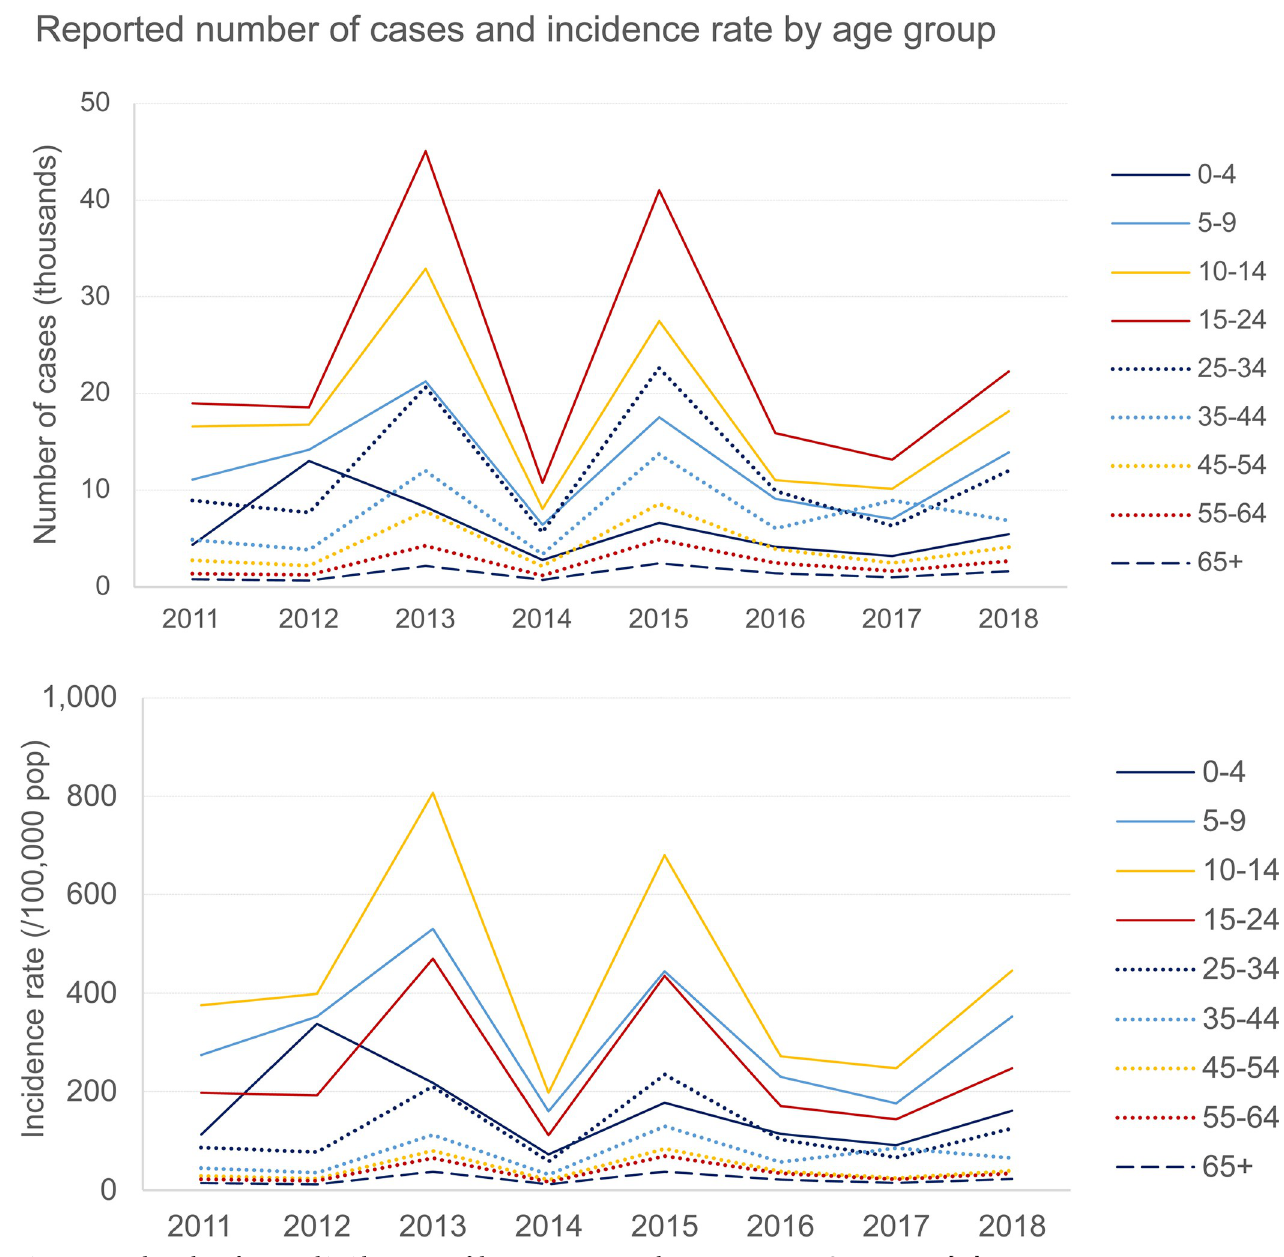
Fig 3. Reported number of cases and incidence rates of dengue per age group between 2011–2018; Source MoPH [12].